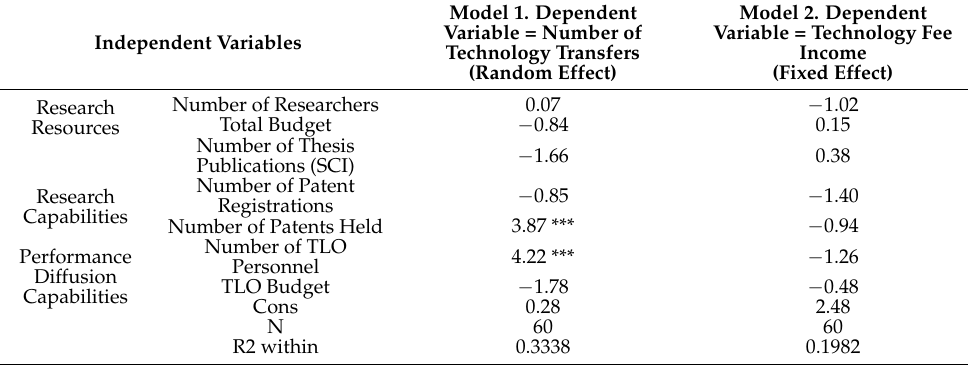
Table 7. Analysis results for public infrastructure